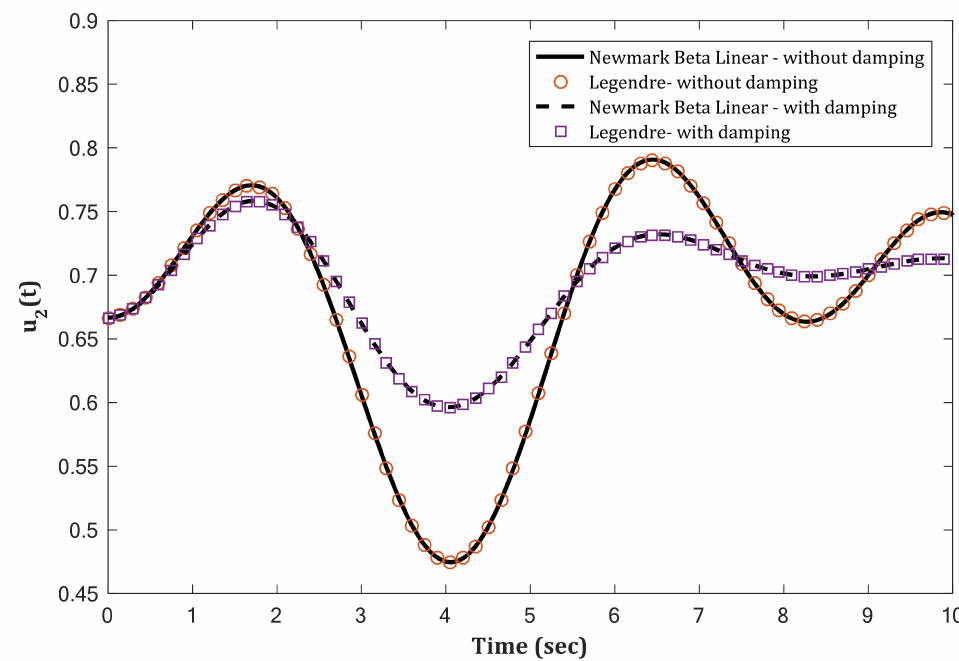
Figure 8. Free vibration analysis of a 3DOF system. Comparison of u 2 ( t ) as a function of time, as obtained using the LGM method or the linear Newmark- β method.